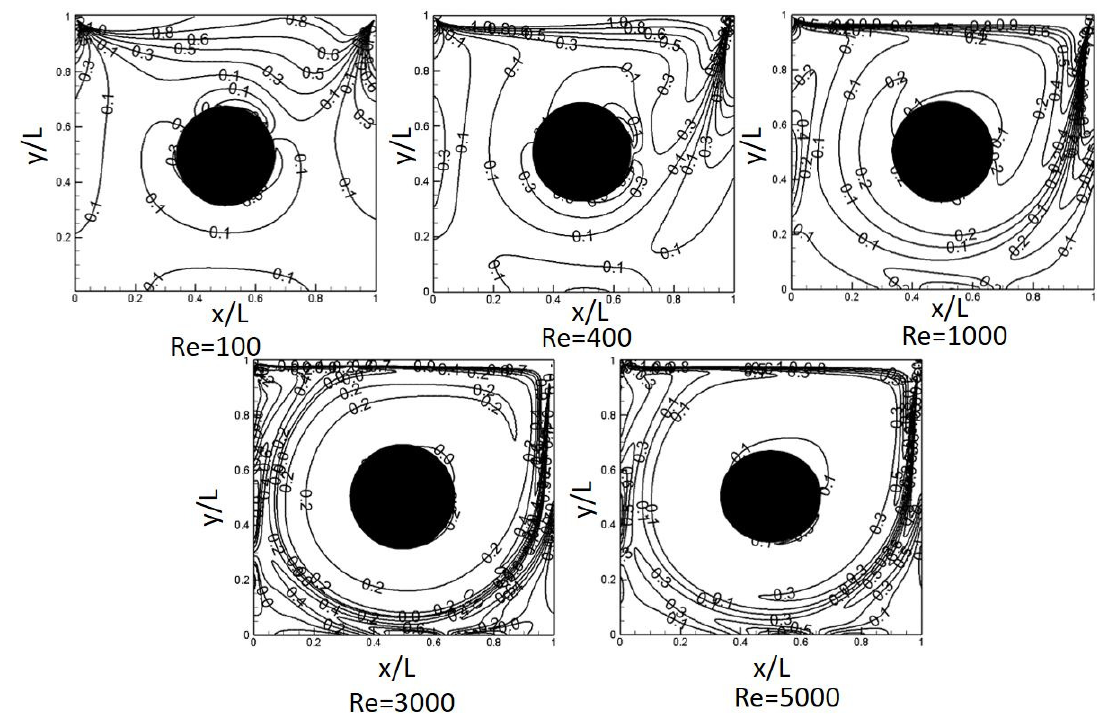
Figure 11. Streamline distribution with variation in Re .